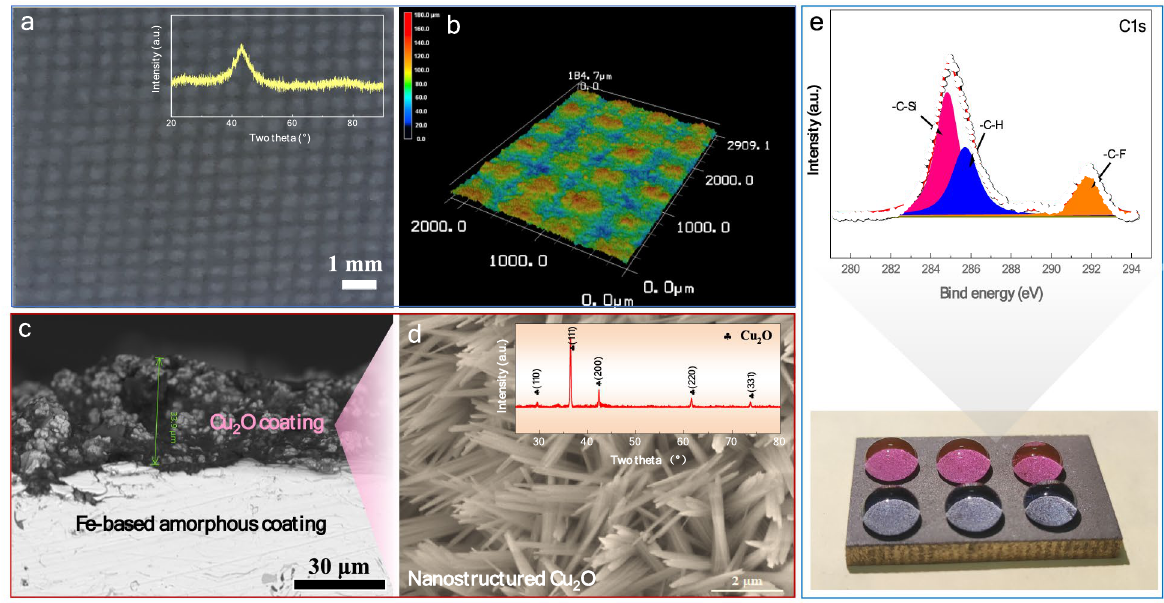
Figure 2. Structure of the as-prepared coating. ( a ) Surface morphology and ( b ) 3D surface topography on the as-sprayed and micro-patterned Fe-based amorphous coating. Inset in ( a ) shows the XRD pattern of the coating before modification. ( c ) Cross sectional and ( d ) surface morphologies of the coating after deposition of Cu 2 O layer. Inset in ( d ) is the XRD pattern of the Cu 2 O layer deposited on amorphous coating. ( e ) Photo of FAS-Cu 2 O modified amorphous coating and XPS spectra from the